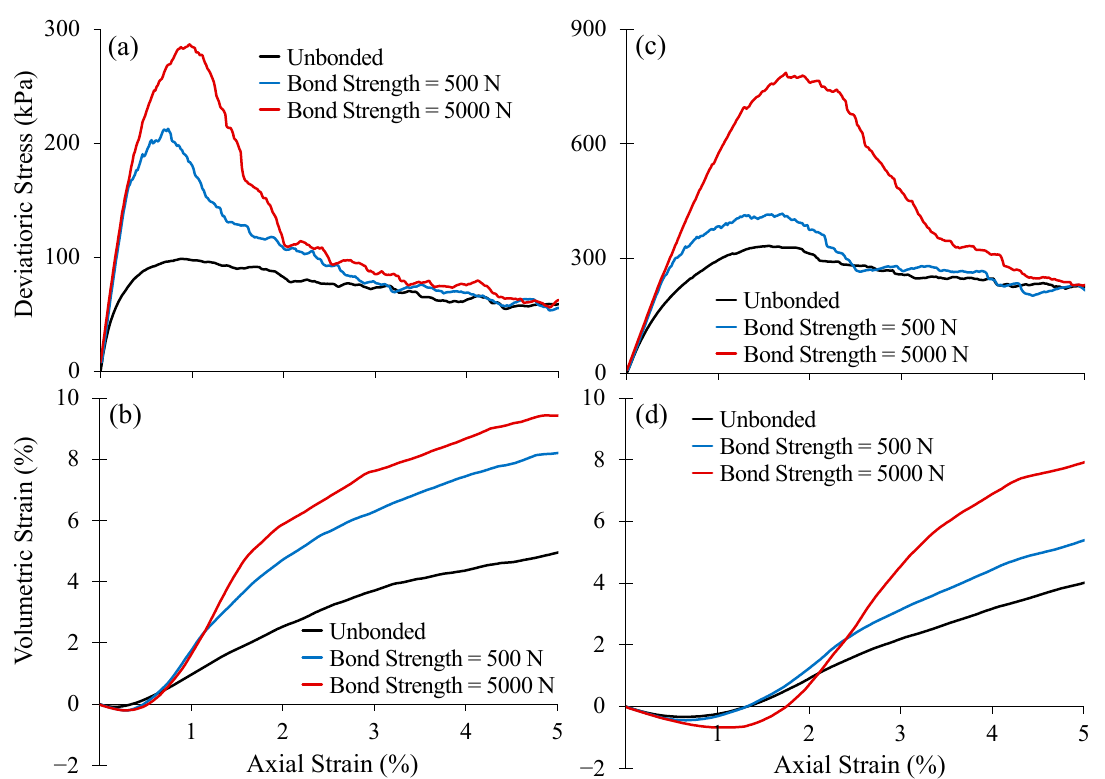
Figure 9. Biaxial test results of the models with different bond strengths subjected to ( a , b ) 50 kPa confining stress; ( c , d ) 100 kPa confining stress.